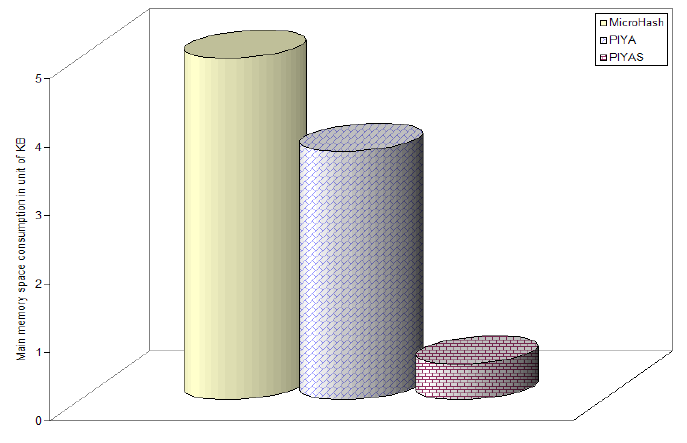
Figure 8. SRAM consumption in KBs for buffering sensor readings.